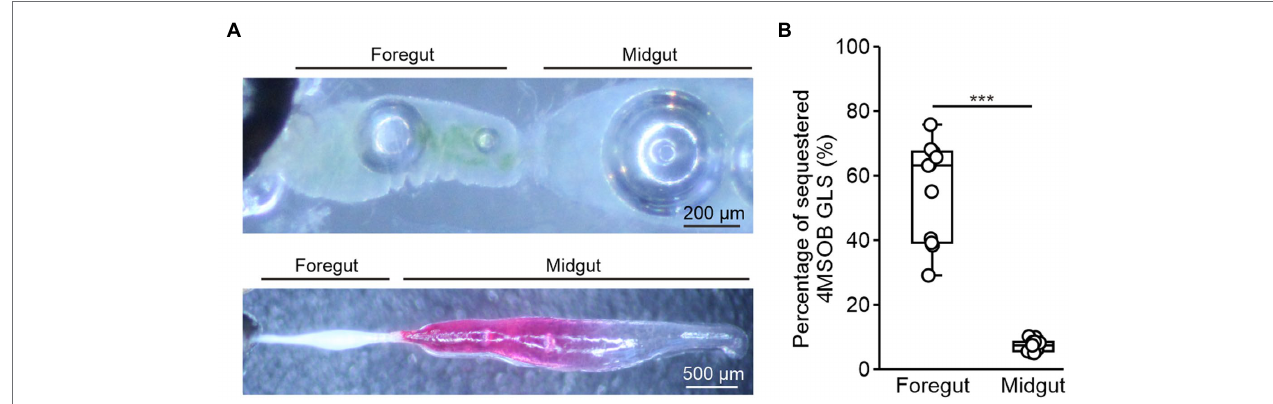
FIGURE 2 | Localization of glucosinolate uptake in adult Phyllotreta armoraciae . (A) Upper picture: Dissected gut with ingested plant material localized in the foregut. Lower picture: Dissected gut with injected leaf extract visualized using amaranth dye. (B) Glucosinolate uptake from the foregut and midgut in P. armoraciae . Guts of newly emerged adults were separated from the remaining body after 15 s of feeding or injection. Dissected tissues were extracted using 80% (v/v) methanol and glucosinolates were quantified by LC–MS/MS. The percentages of sequestered glucosinolates were calculated as the glucosinolate amounts in the remaining bodies relative to the total amounts detected in guts and the remaining bodies (Mann–Whitney U -test, *** p < 0.001, n = 10). Box plots show the median and interquartile range of each dataset.